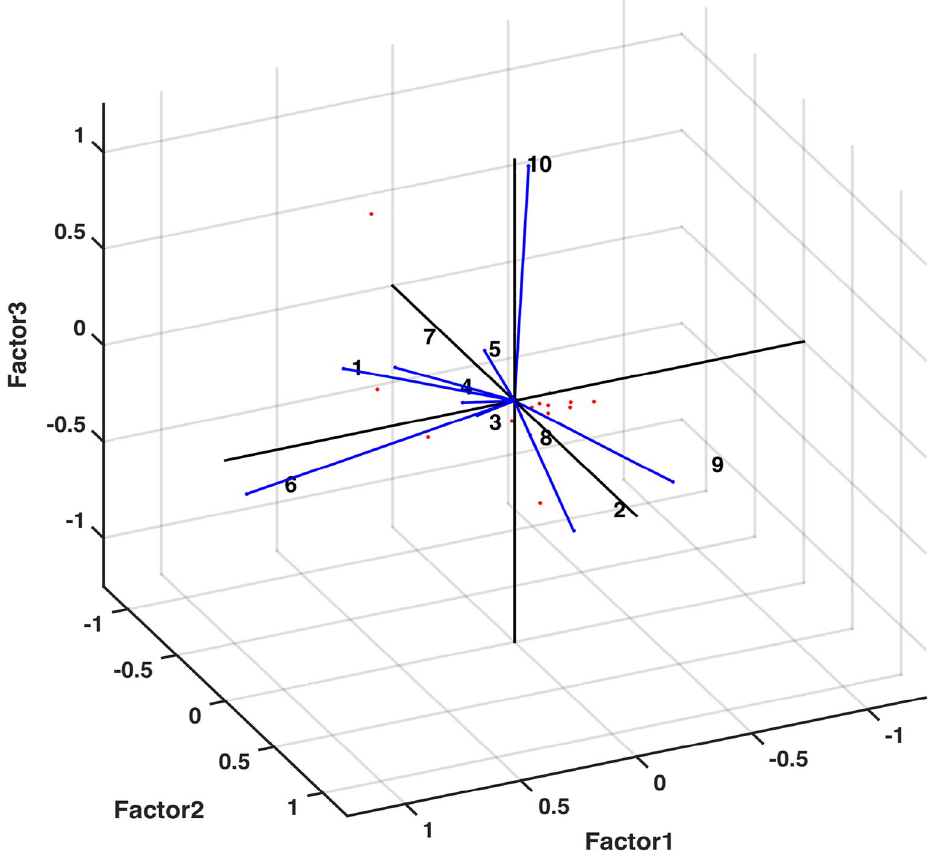
Figure 13. Rotated factors (1–3) score